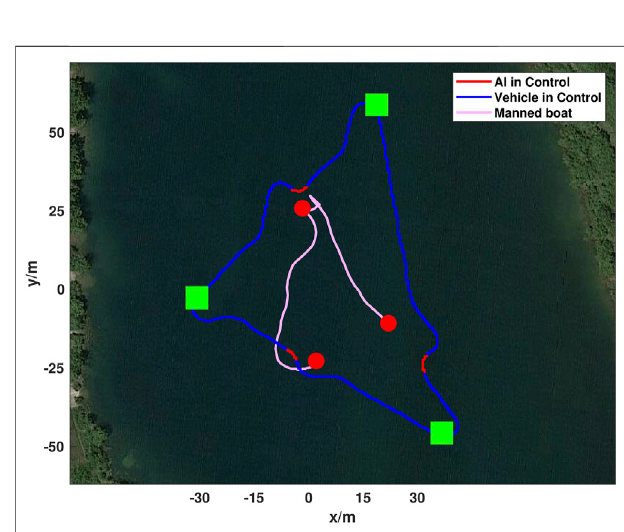
FIGURE 10 | Real-world ASV obstacle avoidance test utilizing a manned boat to inject obstacles into the vehicles path. Mission waypoints are shown in green, ASV DRL agent augmented paths are in red, and the ASV trajectory following the mission path isin blue. The manned boat trajectory isshown inpinkandlocationswhereitwas fi rstidenti fi edasanobstaclebytheDRLagent are shown as red circles. Both trajectories start at the bottom left and progress counter-clockwise. The mission shown took 310 s and covered 398